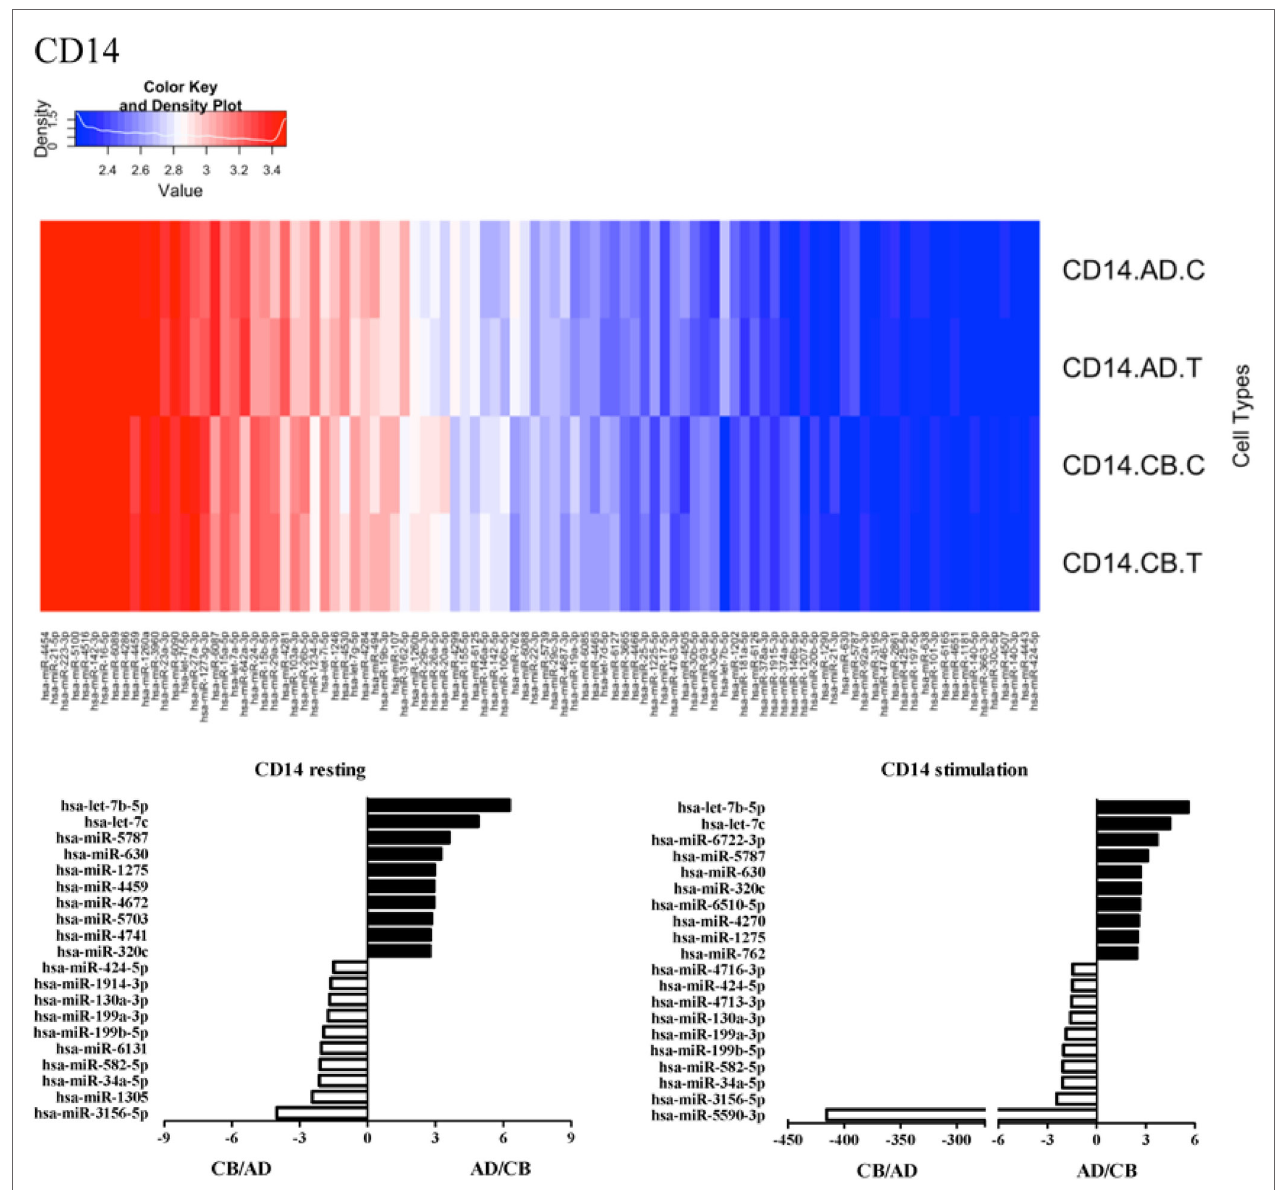
FigUre 6 | Differential microrna profiles between adult and neonatal cD14 + monocytes